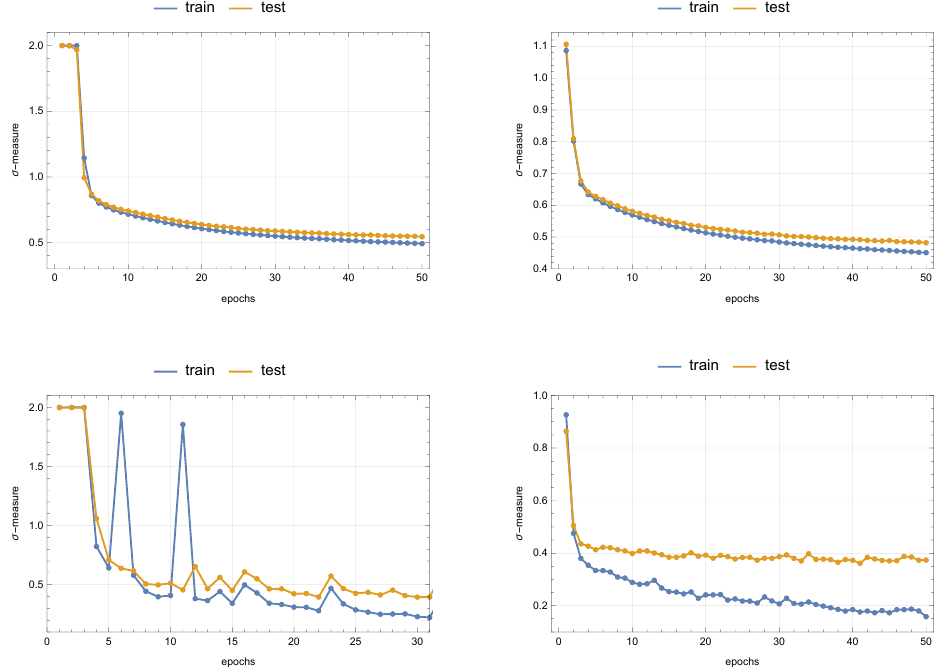
Figure 11 . Evolution of the σ -measure during the course of training for the Tian-Yau mani- fold (2.8). In the experiments in the top row we use the activation functions ReLU (left) and tanh (right), a learning rate of 5 × 10 − 6 , a batch size of 200 and use 1000 nodes in each hidden layer of our neural network. We use 15 , 000 points to train and use a train-test ratio of 90 : 10 . In the experiments in the bottom row, we use the same hyperparameters except the learning rates which are 5 × 10 − 4 and 5 × 10 − 5 respectively for the ReLU (left) and the tanh (right) architectures respectively. To mitigate the issue of over-fitting, we stop training when the training loss stabilises. Further, we use the sigma measure alone as the loss. Experiments using the logistic sigmoid acti- vation did not yield good